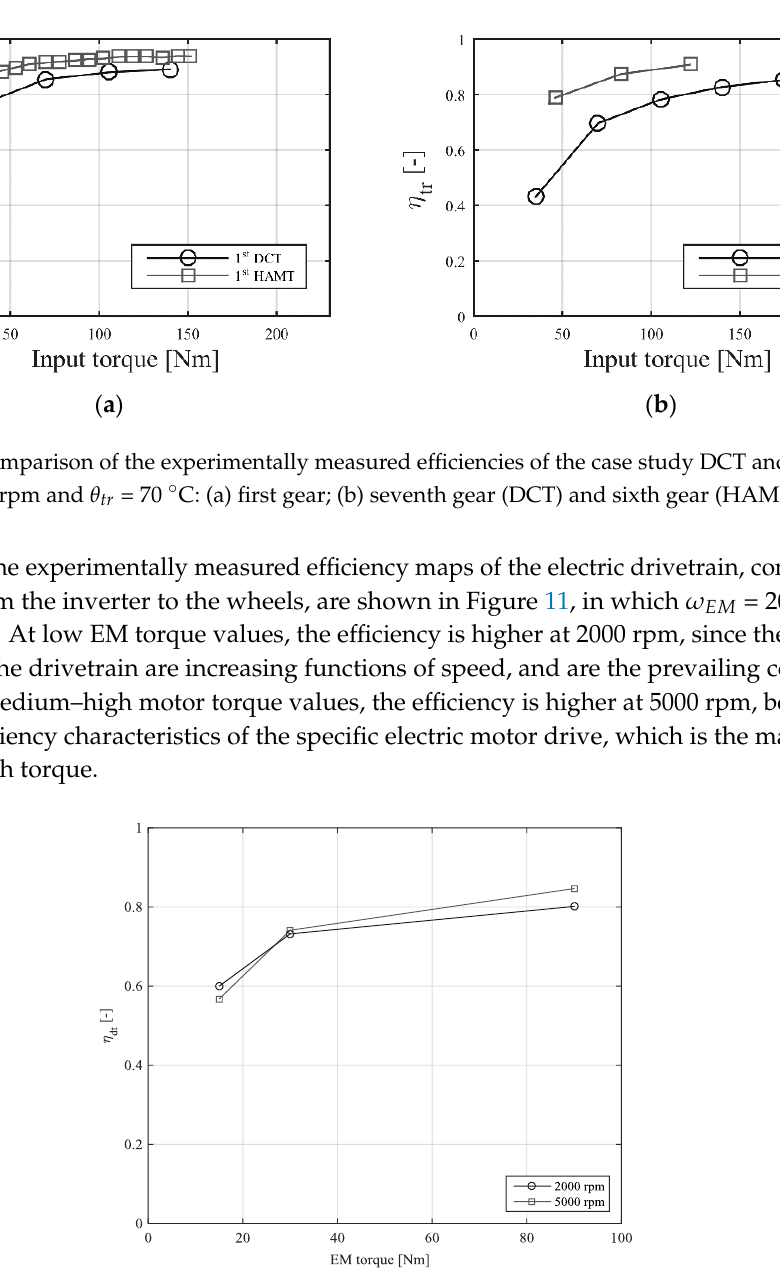
Figure 11. Sample of the experimentally measured electric drivetrain efficiency of the case study HAMT in fully electric mode (first EM gear), at 𝜔 𝐸𝑀 = 2000 rpm and 𝜔 𝐸𝑀 = 5000 rpm.